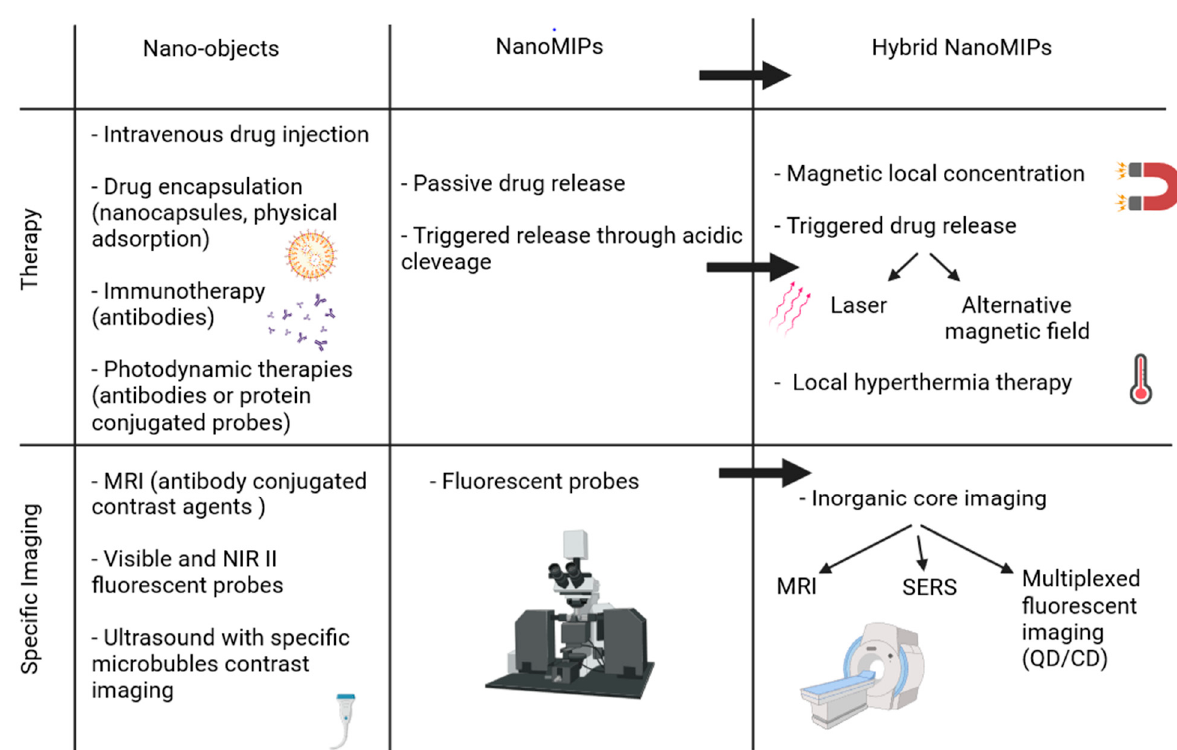
Figure 9. Non-exhaustive comparison of possible applications for therapy or bioimaging between usual nano-objects, molecularly imprinted polymers, and their hybrid counterpart.